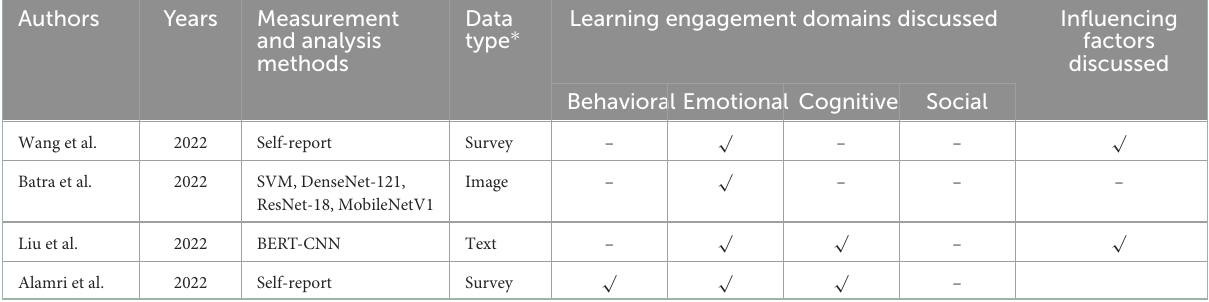
which are enclosed in quotation marks represent actual